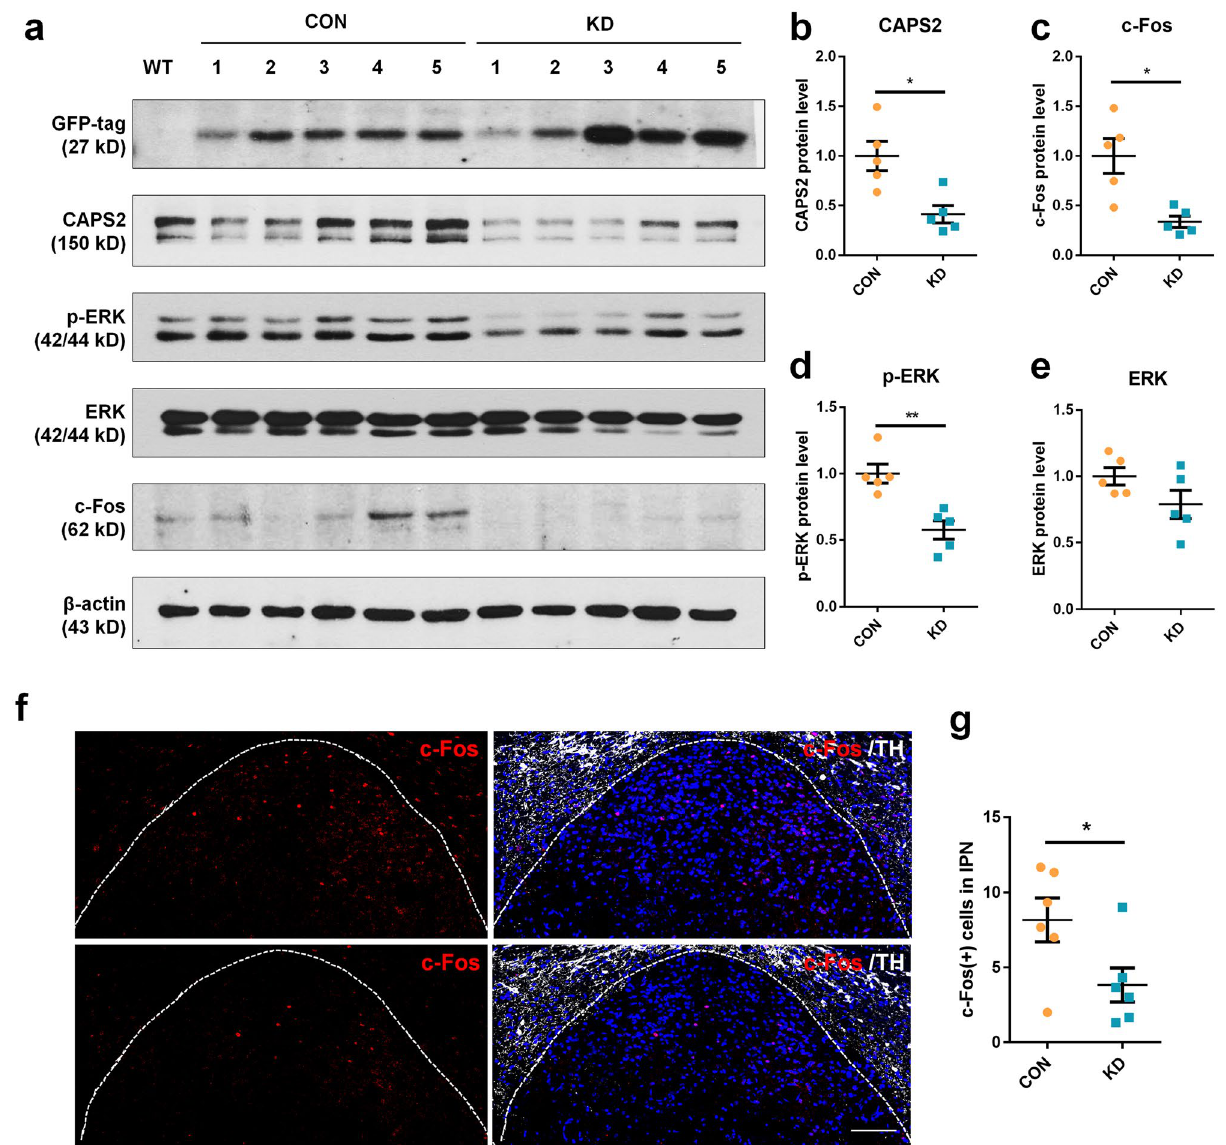
Figure 4. CAPS2 knockdown in the MHb leads to decreased neuronal activity in the IPN. ( a ) Western blot analysis from the IPN tissue of MHb AAV-sh-vehicle (CON) or AAV-sh-CAPS2 (KD) injected mice. ( b – e ) Western blot band intensity for CAPS2, c-Fos, p-ERK, ERK. AAV-sh-CAPS2 (KD) virus injection reduced the CAPS2 protein levels in IPN and diminished c-Fos and p-ERK protein levels. Uncropped images are presented in Supplementary Figure S5. ( f and g ) Representative immunohistochemistry image ( f ) and c-Fos-positive cell number ( g ) in IPN of control and MHb CAPS2 knockdown mouse. The number of c-Fos-positive cells was decreased in the MHb CAPS2 knockdown group. Data represent mean ± SEM, * P < 0.05, ** P < 0.01 (WB, CON, n = 5; KD, n = 5 mice; CAPS2: P = 0.016; c-Fos: P = 0.016; p-ERK: P = 0.008; ERK: P = 0.222; Mann–Whitney U -test; IHC, CON, n = 6; KD, n = 6; P = 0.041, Student’s t -test; Scale bars, 100 MHb CAPS2 knockdown alters neuronal activity in the monoamine centers. Monoaminergic centers, including VTA and DRN, are important structures for mood-related behaviors. Recent findings have shown that activating VTA dopamine neurons produce reward, and inhibiting VTA dopamine neurons generate despair-like symptoms 27–29 . VTA receives serotonergic and glutamatergic input from DRN 30,31 , which affects the response to reward 32–34 . As MHb CAPS2 knockdown mice present despair-like symptoms, we thought that neu- ronal activity in the VTA would differ between the knockdown and control groups. The IHC analysis revealed that indeed c-Fos-positive cell numbers in the VTA were significantly decreased in knockdown mice (n = 6 for each group, Student’s t -test; c-Fos-positive cells: 53.33 ± 8.38 vs. 17.61 ± 8.09, T (10) = 7.511, P < 0.001; Fig. 5a and b). In addition, the number of tyrosine hydroxylase (TH)/c-Fos double-positive cells was significantly decreased in MHb CAPS2 knockdown mice, meaning decreased dopaminergic neuronal activity in the VTA (n = 6 for each group, Mann–Whitney U -test; TH/c-Fos double-positive cells: 7.11 ± 2.51 vs. 1.28 ± 0.61, P = 0.002; Fig. 5a and